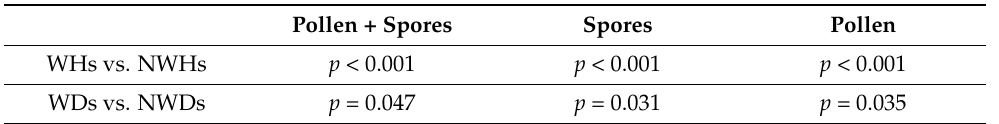
Table 4. WHs and NWHs (evening + night vs. morning + afternoon) inside WDs; WDs vs. NWDs. (Mann-Whitney Rank Sum Test).